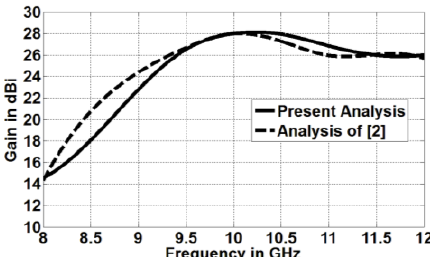
Figure 8: Comparison between calculated antenna gains of